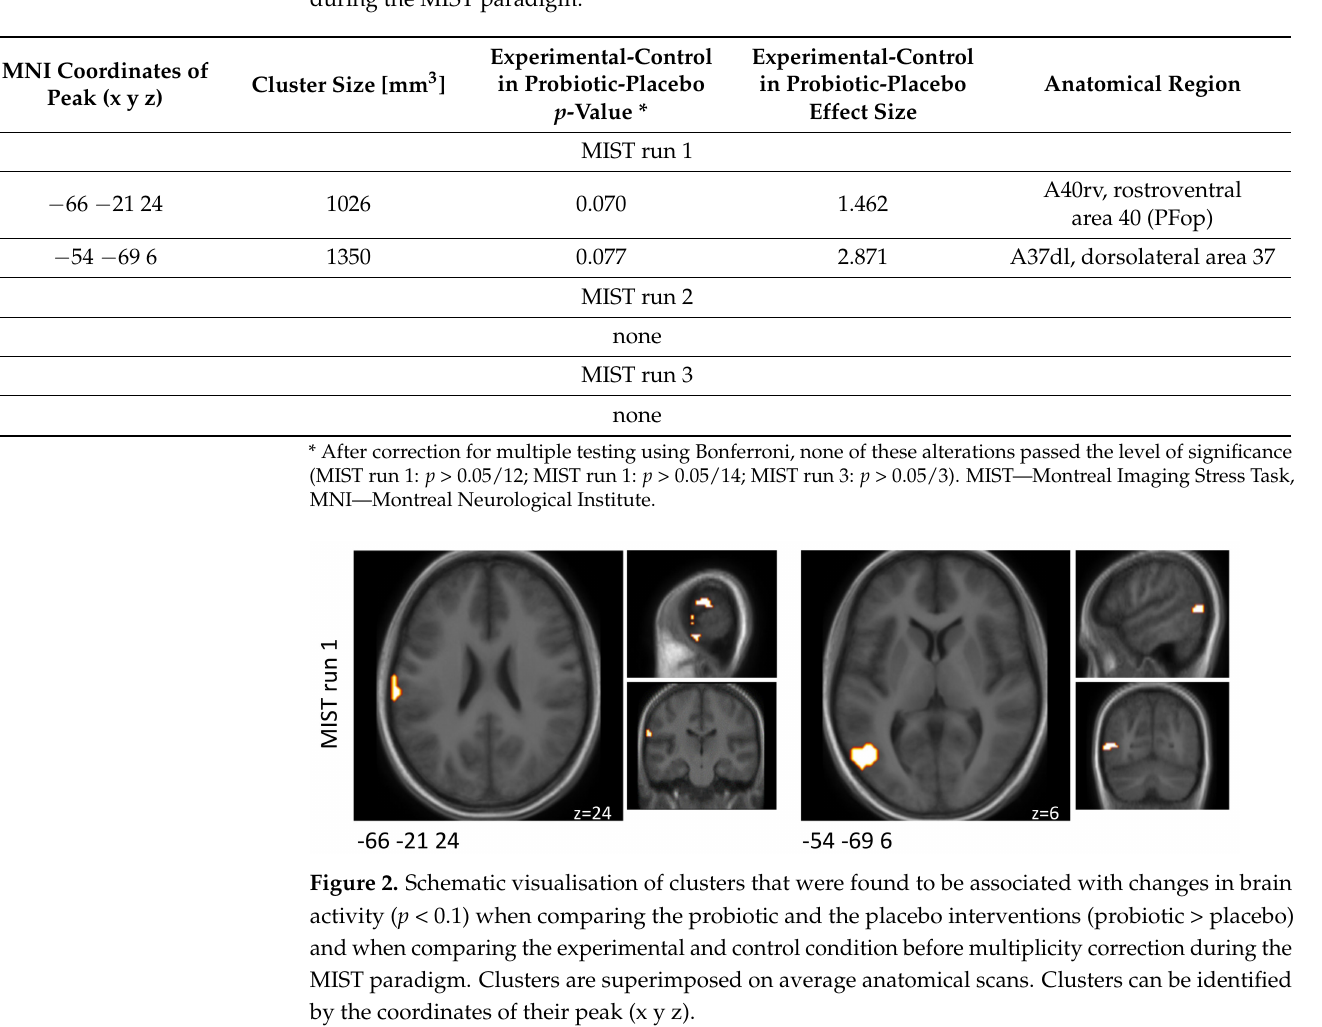
Table 2. Clusters that were found to be associated with changes in brain activity ( p < 0.1) between both interventions when comparing the experimental and control condition before multiplicity correction during the MIST paradigm.